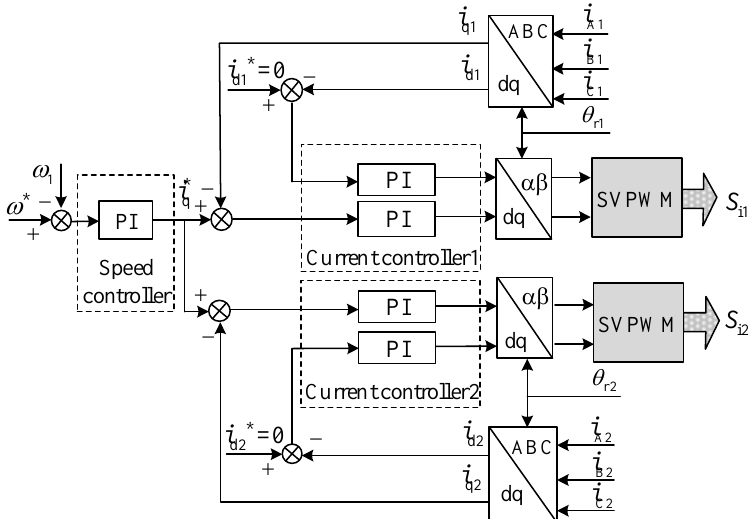
Figure 4. Inverter controller based on master-slave